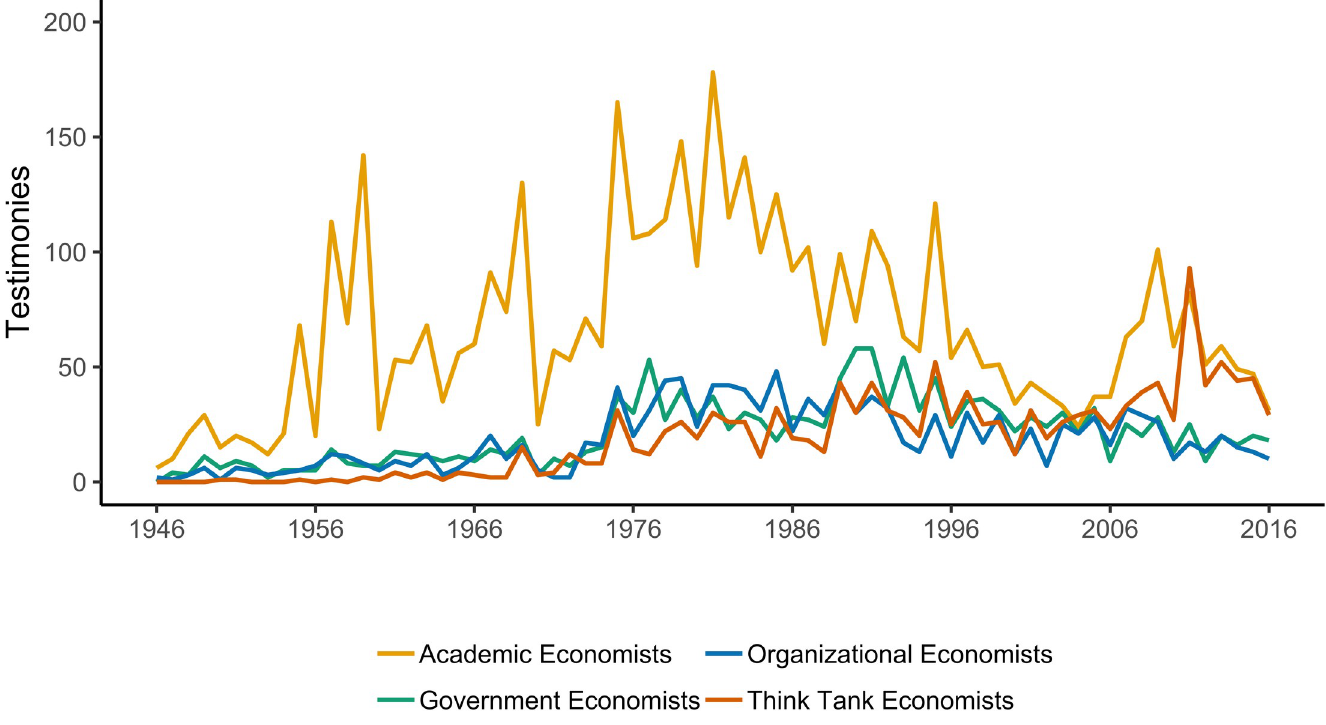
Fig 4. Sources of economist